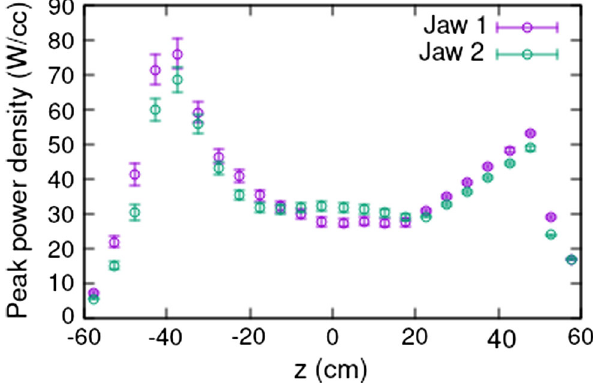
FIG. 3. Peak power density profile on the most exposed secondary collimator for 0.2 h BLT.